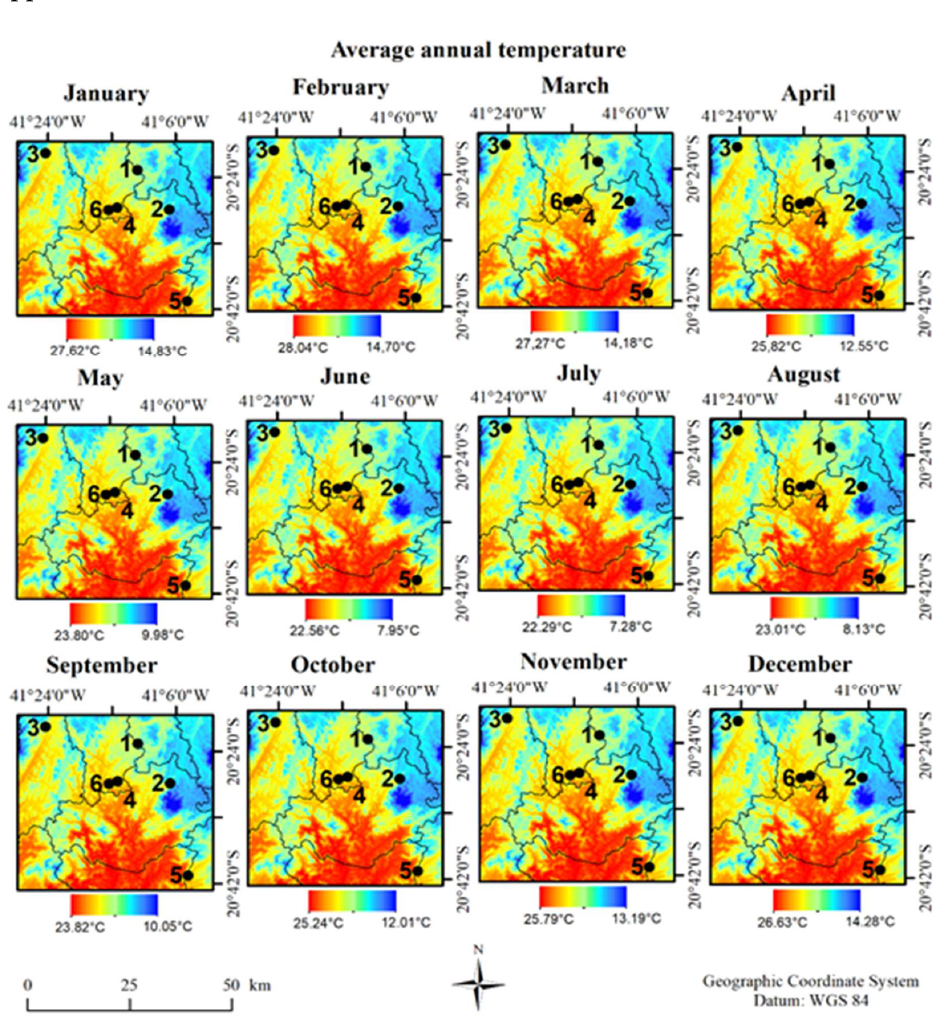
Figure A1. Average annual temperature of the Conilon-producing areas under study. Location: Venda Nova do Imigrante (1), Castelo (2), Muniz Freire (3), Conceição do Castelo 1 (4), Vargem Alta (5), and Conceição do Castelo 2 (6).